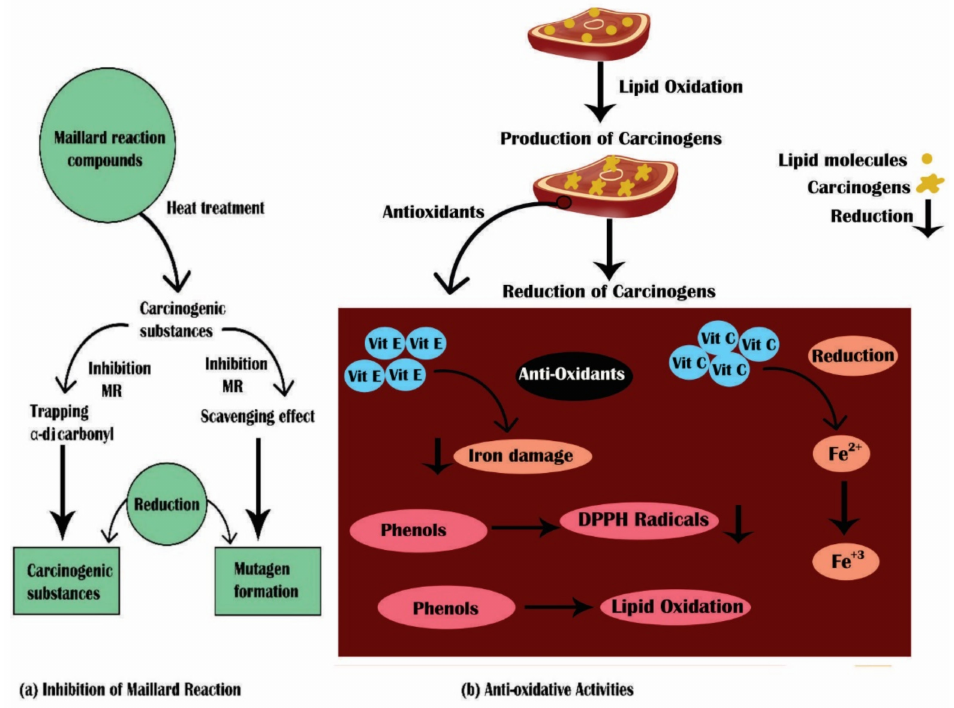
Figure 2. Proposed mechanism of action of natural products on carcinogenic substances. ( a ) Inhibition of the Maillard reaction; ( b ) antioxidative